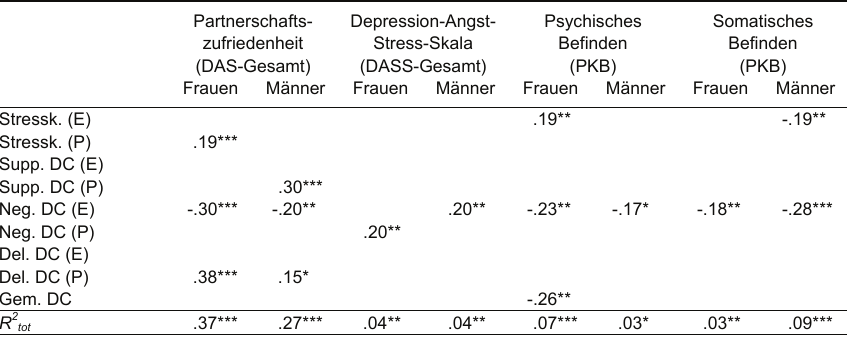
Tab. 7: Multiple Regressionsanalysen (standardisierte Koeffizienten, stepwise) zur prognostische Validität in Bezug auf